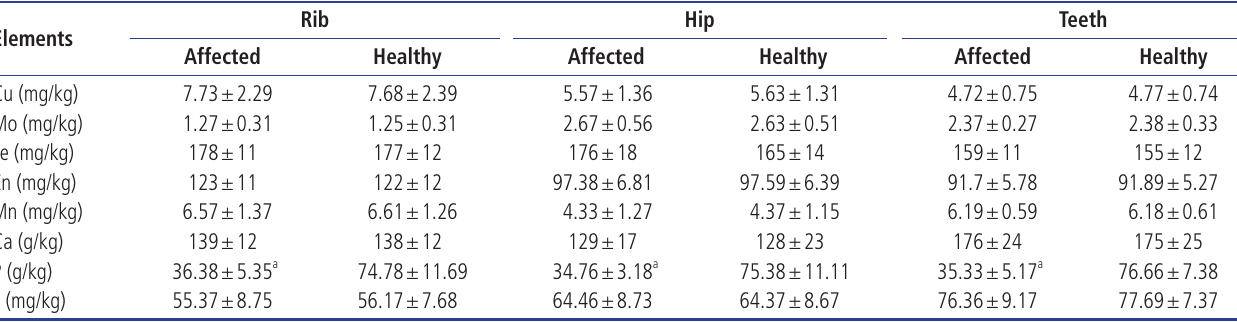
Table 6. Mineral element contents in bones and teeth of Qianbei-Pockmarked goats Elements